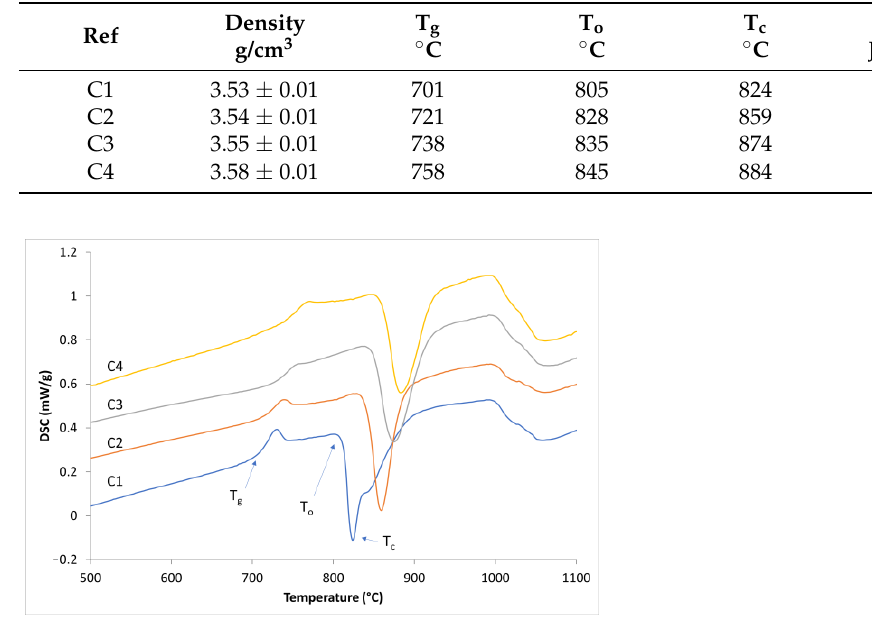
Figure 5. DSC curves of the parent glasses.